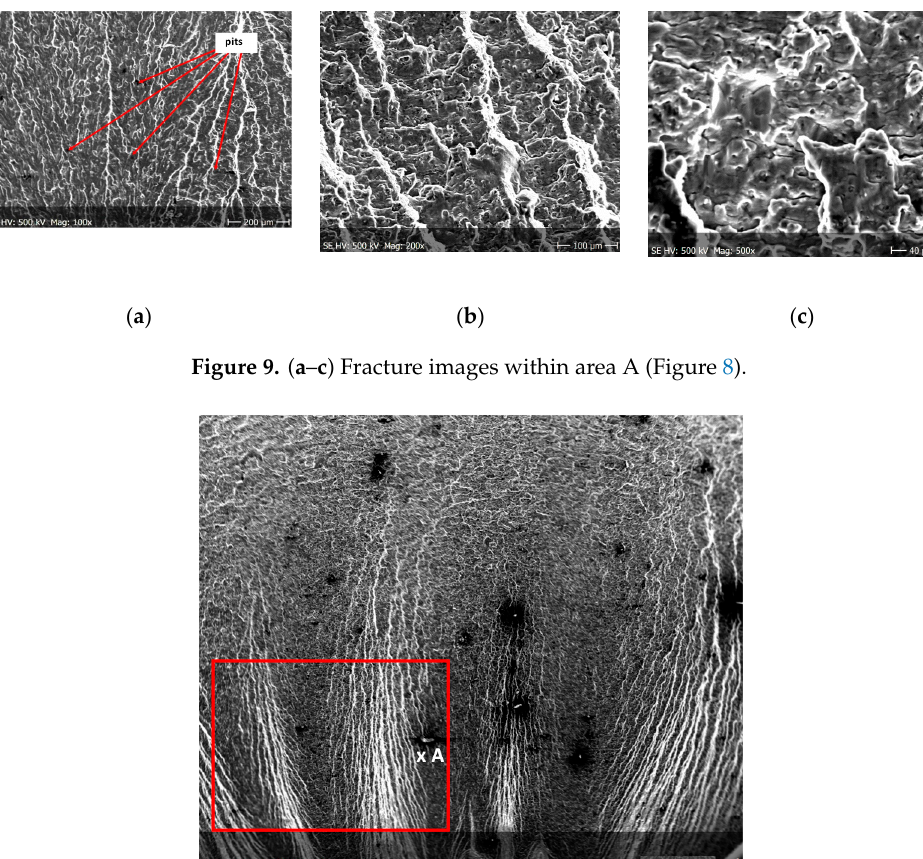
Figure 10. Fracture images after 14 days of testing in tap water (sample shown in Figure 4b).